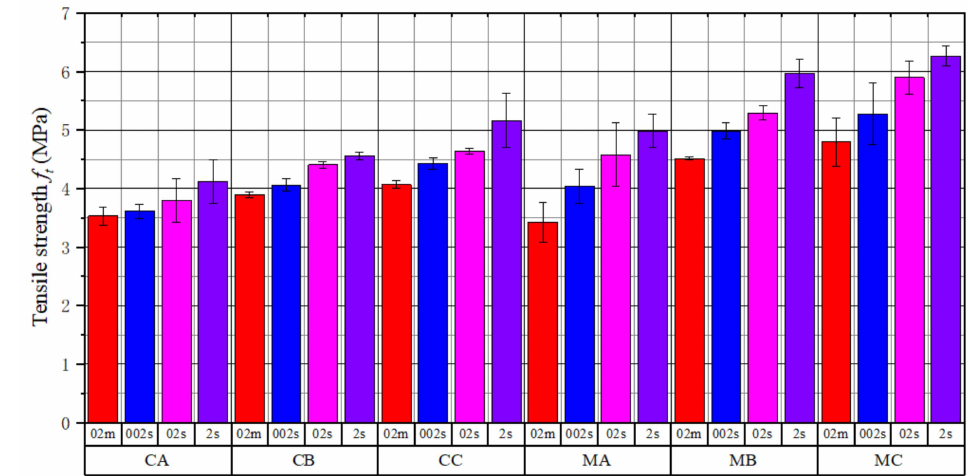
Figure 5. Statistical chart of tensile strength of